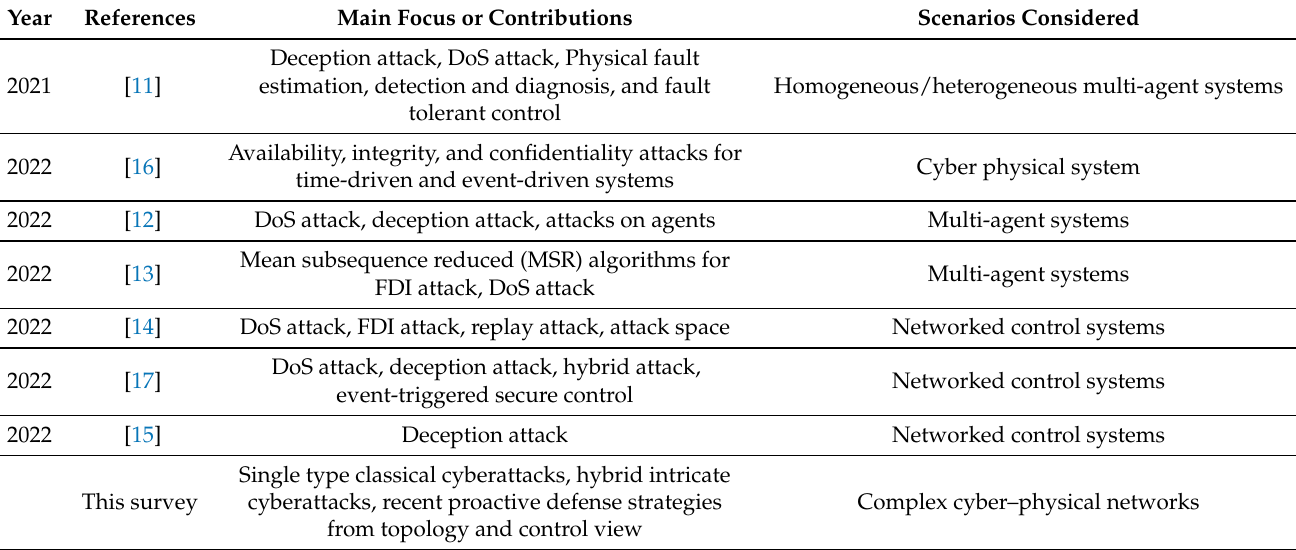
Table 1. Brief summary and comparisons of several existing survey